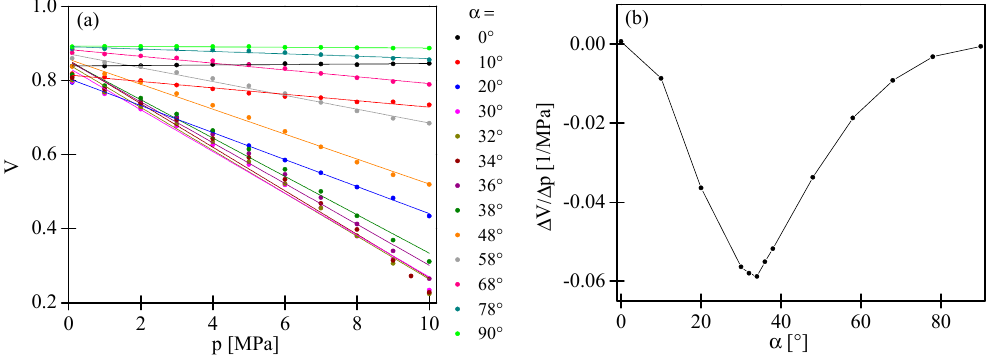
Figure 9. Variation of the intermodal fringe visibility versus applied pressure ( a ) and corresponding sensitivity ( b ) for different azimuths of the input polarization state.